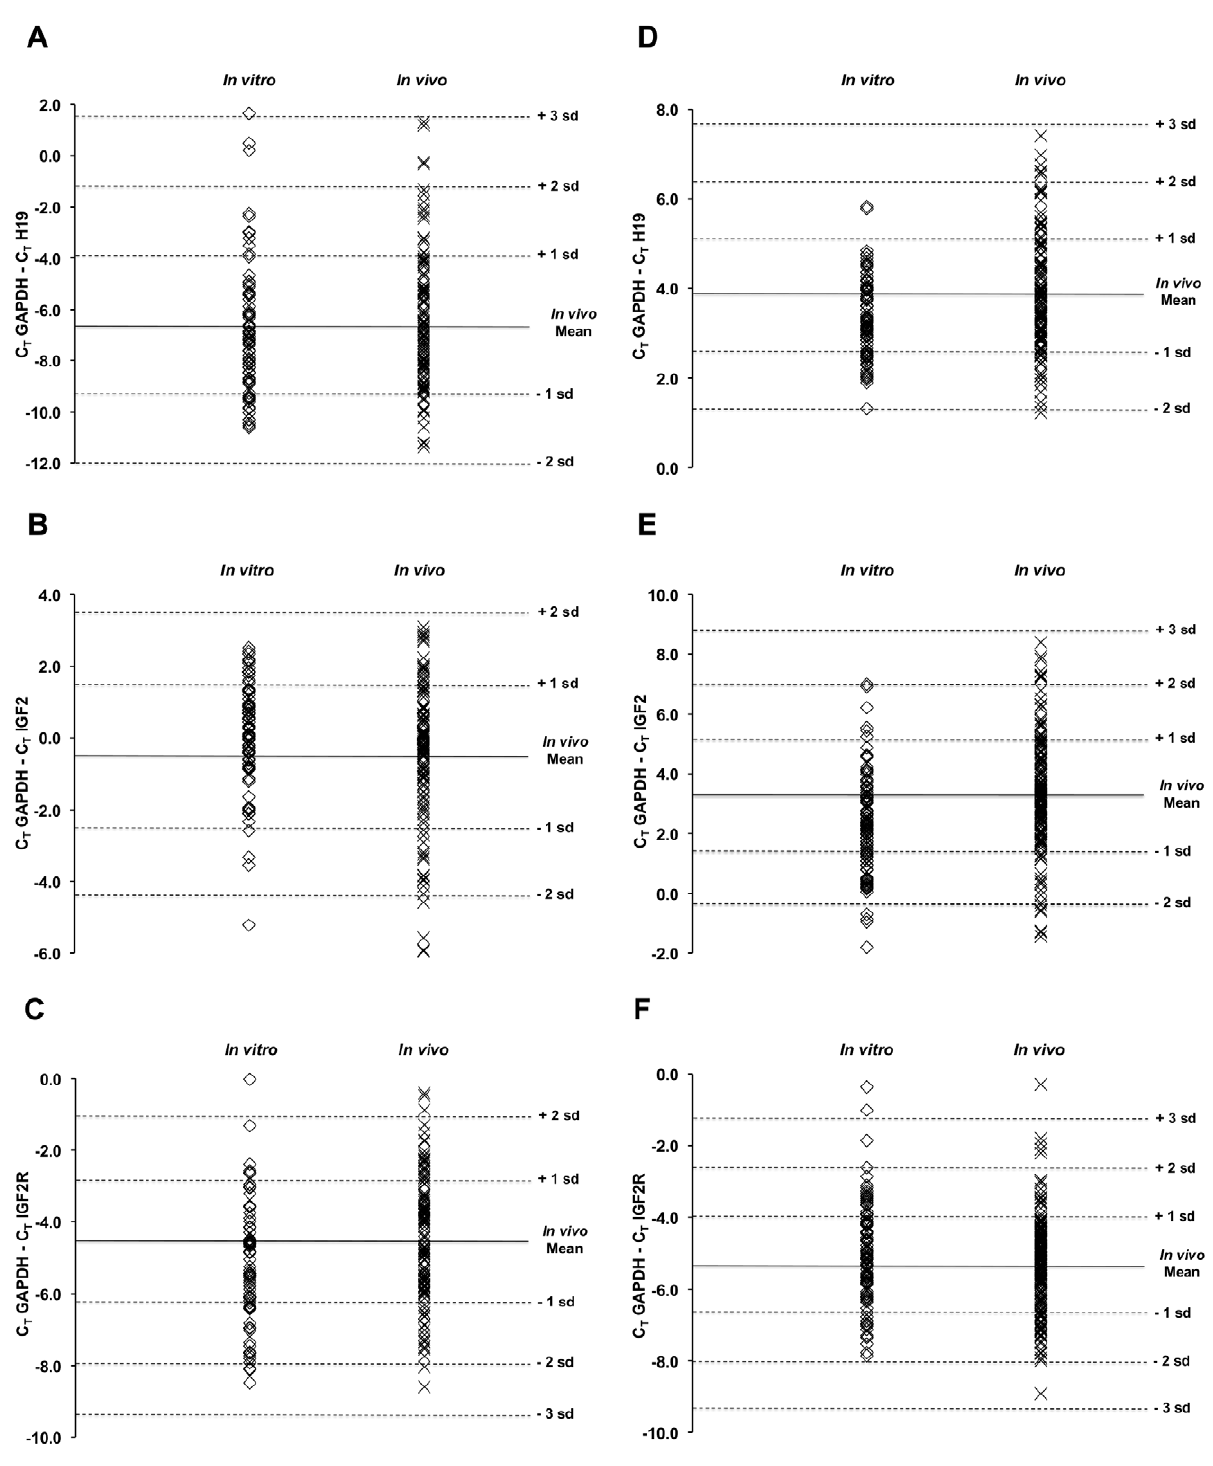
Figure 4. Scatter plots showing mRNA transcript levels in the invitro and invivo populations. Each symbol represents the mRNA level in one individual. (A) H19 in cord blood ( in vitro n=73, in vivo n=118, fold change 0.88, P =0.8774), (B) IGF2 in cord blood ( in vitro n=77, in vivo n=116, fold change 1.03, P =0.5551), (C) IGF2R in cord blood ( in vitro n=75, in vivo n=121, fold change 0.61, P =0.0039), (D) H19 in placenta ( in vitro n=84, in vivo n=135, fold change 0.72, P =0.0193), (E) IGF2 in placenta ( in vitro n=98, in vivo n=160, fold change 0.52, P , 0.0001), and (F) IGF2R in placenta ( in vitro n=97, in vivo n=148, fold change 1.18, P =0.2227).